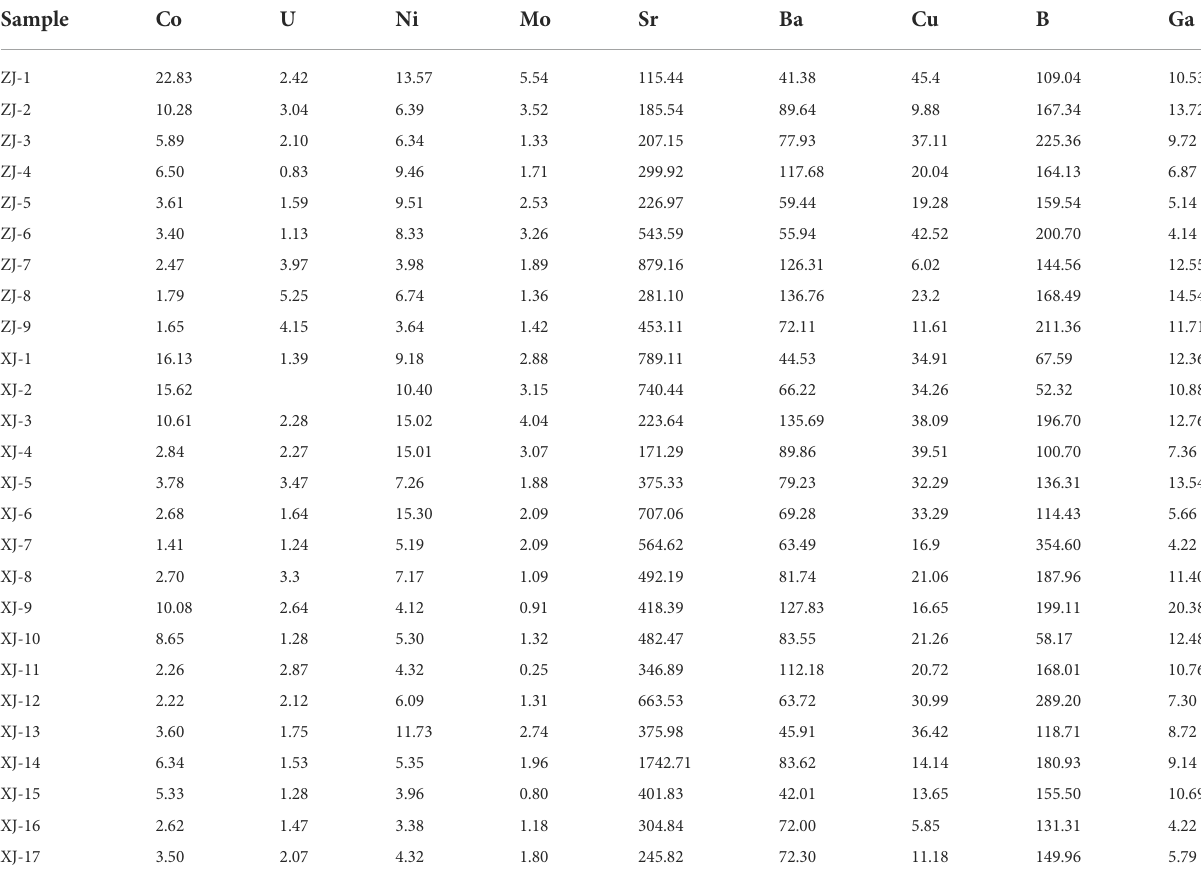
TABLE 3 Element contents related to sedimentary environment of coals in the Shanxi Formation ( μ